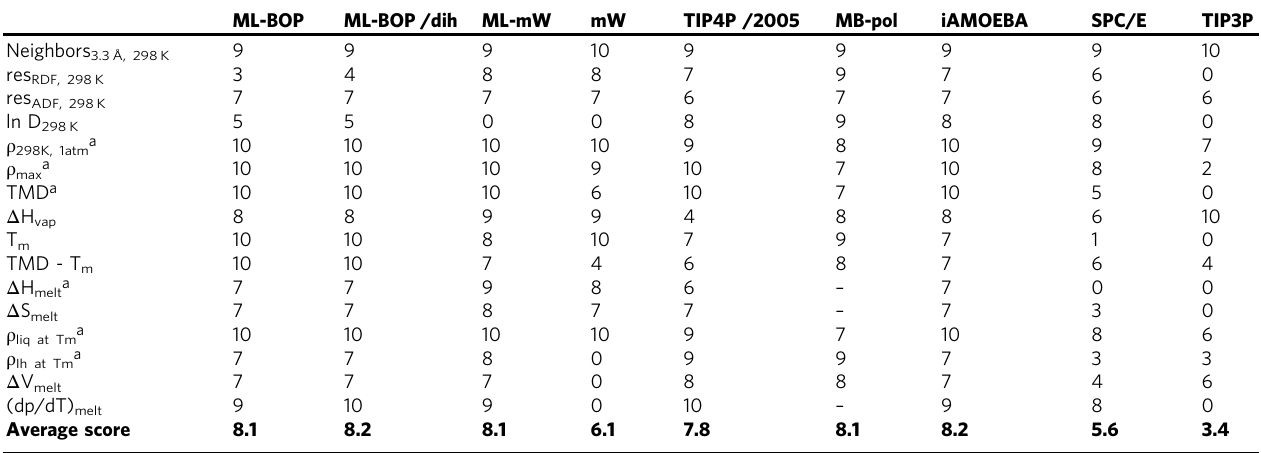
Table 1 Performance of ML models compared to other popular water models